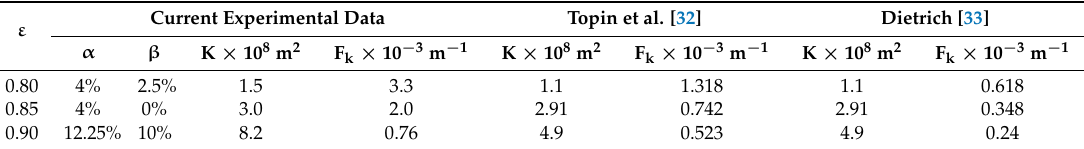
Comparison of permeability and inertial coefficients of the SCSSFFC/Al 2 O 3 and foam